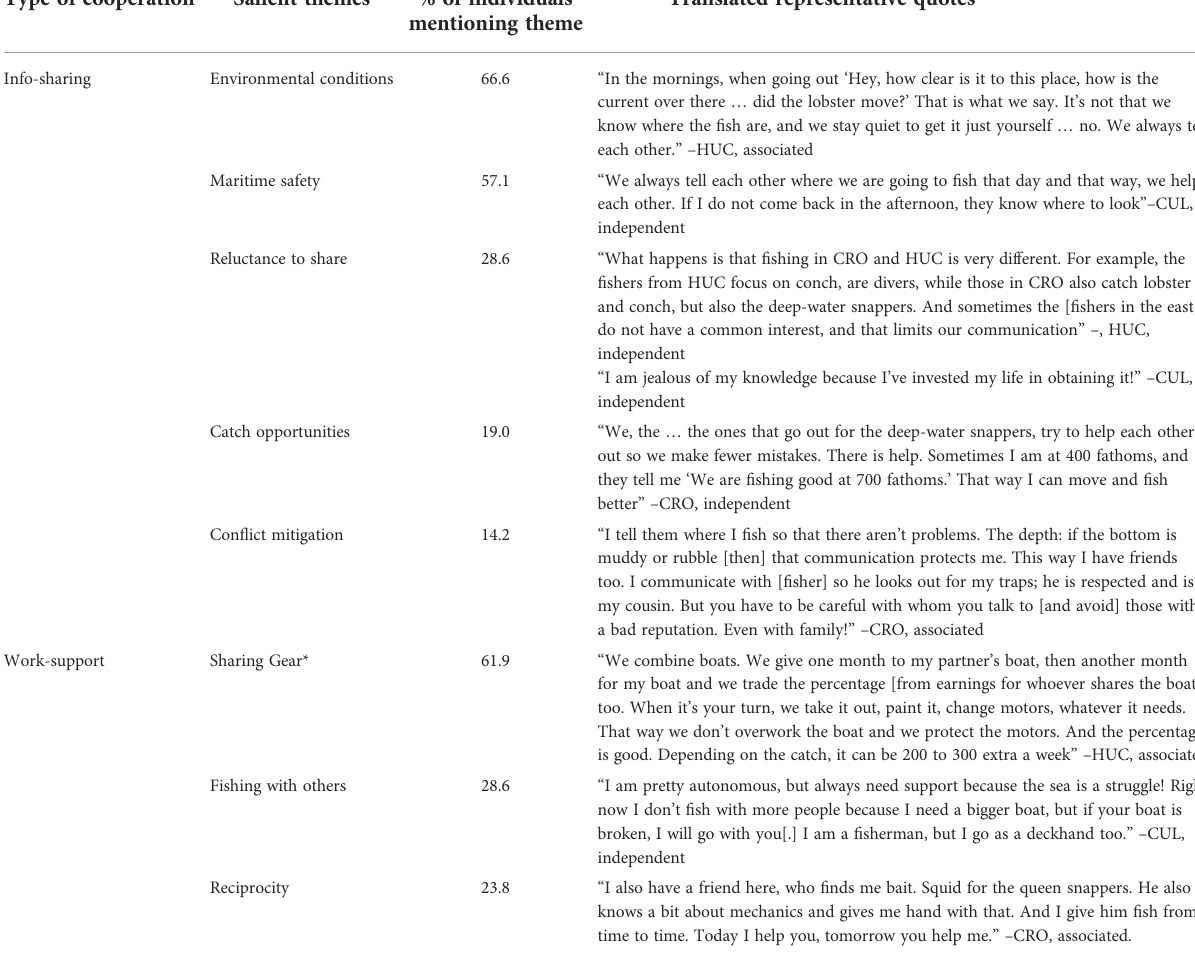
TABLE 2 Emergent explanations from commercial fi shers for their cooperative behaviors (n =